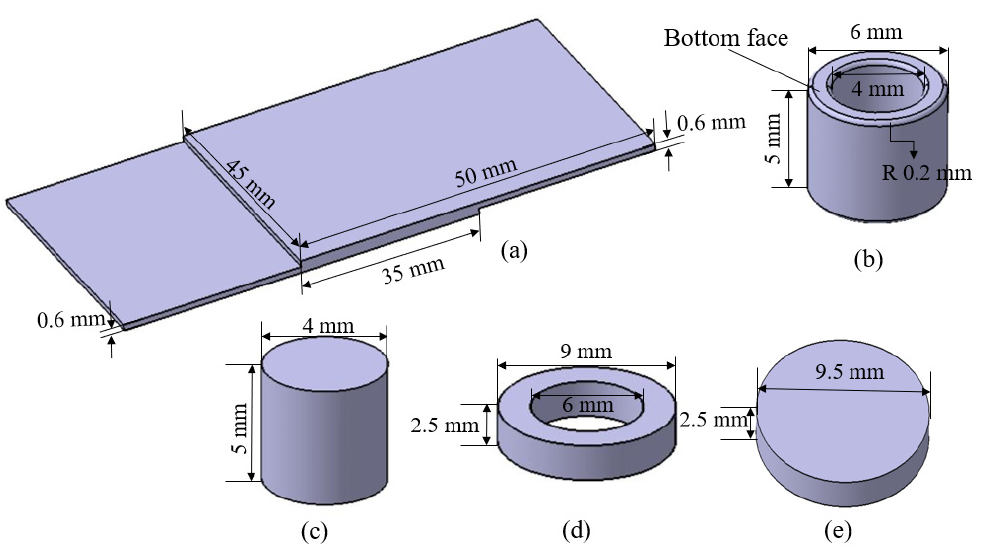
Figure 2. Geometries used for the numerical model with detailed dimensions ( a ) Workpiece; ( b ) Shoulder; ( c ) Probe; ( d ) Clamping Ring; ( e ) Banking Anvil.